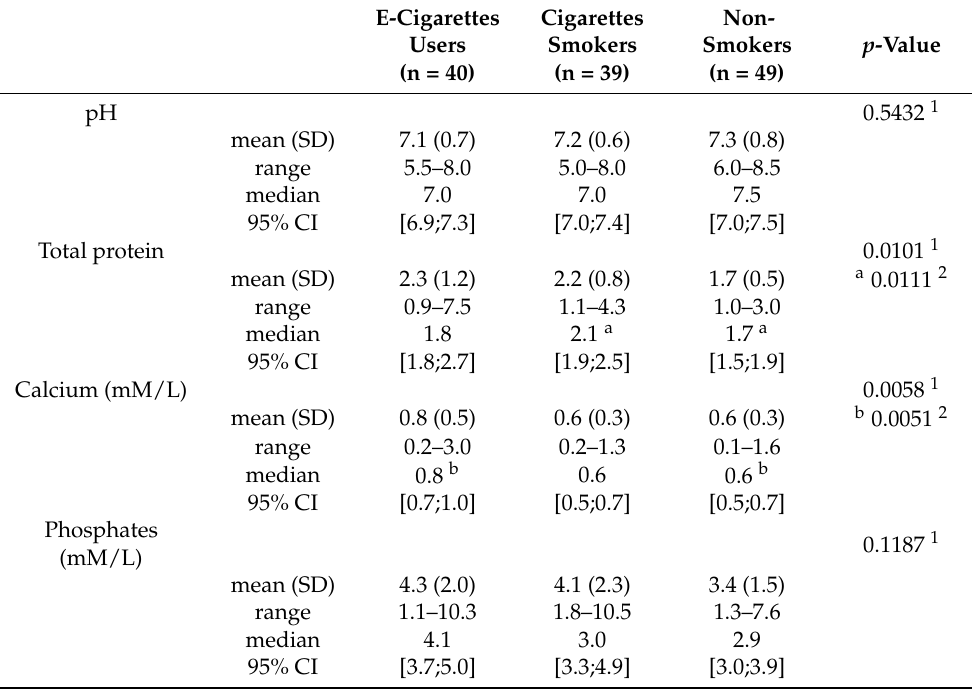
Table 1. Values of unstimulated saliva pH and concentration of total protein, calcium, and phosphate concentration among e-cigarette users, traditional cigarette smokers, and